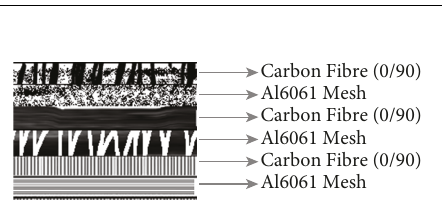
Figure 2: FML layers of the laminate.